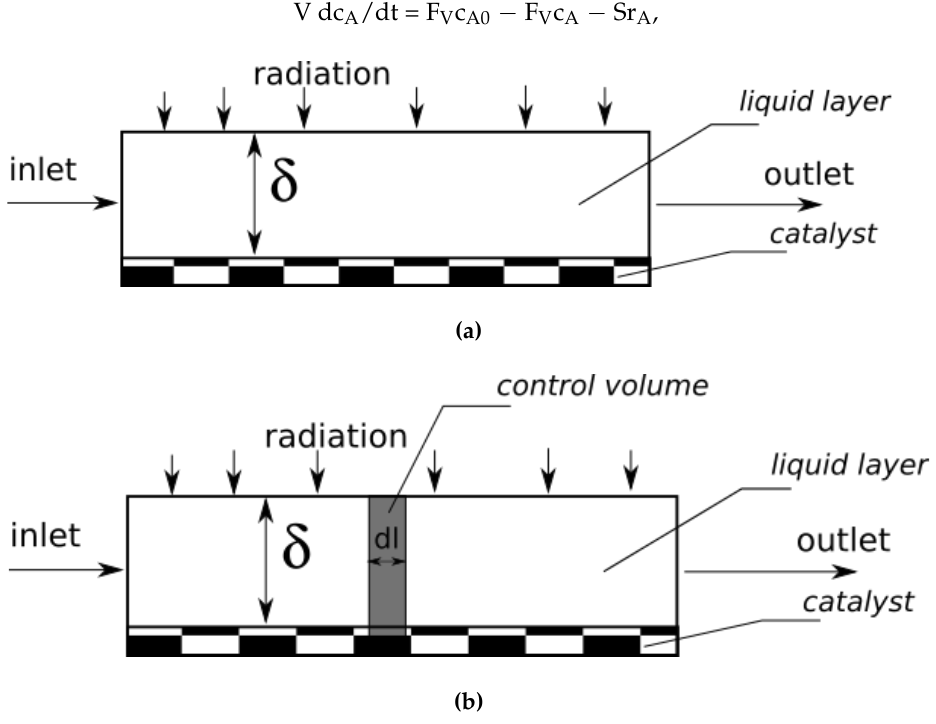
Figure 1. The schematic drawing of the modeled reactor: ( a ) the CSTR approach where the control volume is the total liquid volume in the reactor; ( b ) the control volume is symbolically shown as a gray